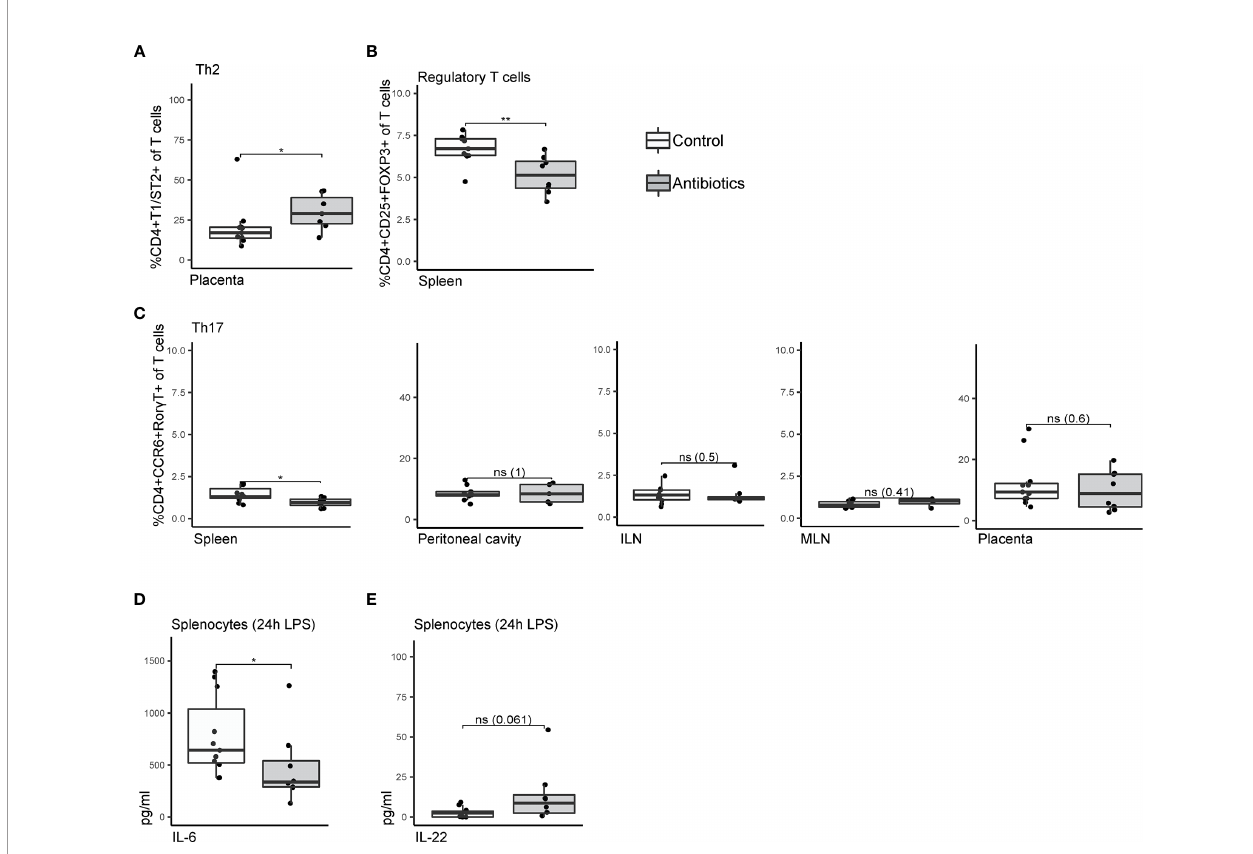
FIGURE 3 | Univariate analysis comparing T cell subsets of antibiotic-treated and control mice. (A) Frequencies of T helper 2 cells within T cells isolated from placental tissue, staining CD4 + T1ST2 + . (B) Splenic CD4 + CD25 + FOXP3 + regulatory T cells as frequency of total T cells. (C) CD4 + CCR6 + RORT + T helper 17 cells isolated from spleen, peritoneal cavity lavage fl uid, inguinal lymph nodes, mesenteric lymph nodes, and placenta. (D) Concentrations of IL-6 and (E) IL-22 in supernatant of splenocytes after 24h lipopolysaccharide stimulation. Cytokine expression levels were corrected for concentrations measured in unstimulated splenocytes. Data were compared by Mann-Whitney/Wilcoxon tests (non-parametric), *p < 0.05 **p < 0.01. ILN, Inguinal lymph nodes; LPS, lipopolysaccharide; MLN, mesenteric lymph nodes; ns, non-signi fi